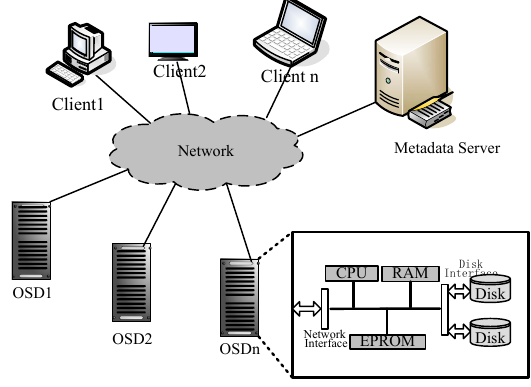
Fig. 1. The architecture of the object-based storage system